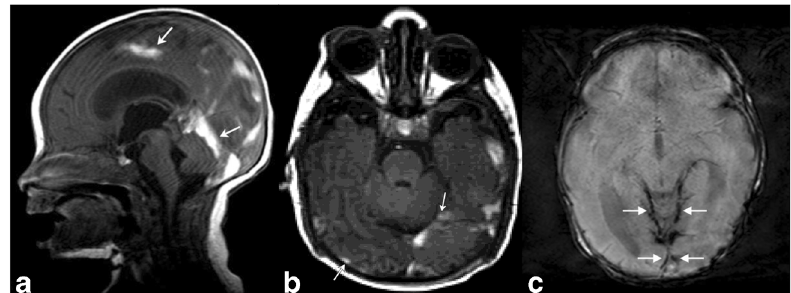
Fig. 8 Subdural Hematoma Brain MRI in a 6-day-old term neonate with history of vacuum-assisted delivery. Sagittal T1 (a) MR image demonstrates subdural hematomas tracking along bilateral occipital lobes and along the tentorium. Another 8-day-old term neonate with history of prolonged rupture of membranes shows subdural hemorrhage